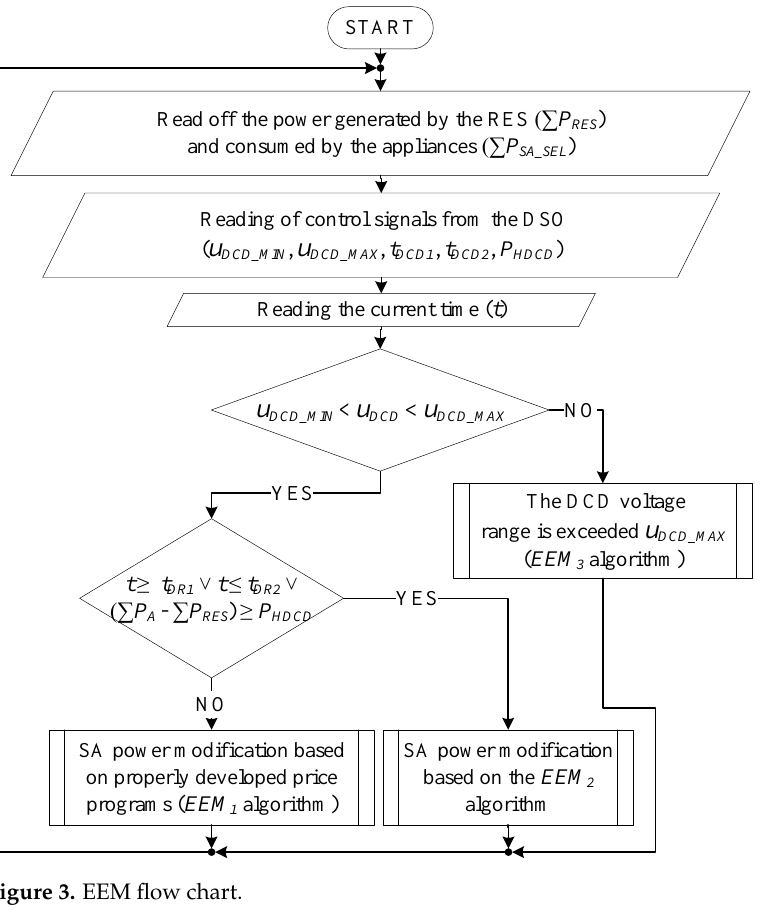
Figure 3. EEM flow